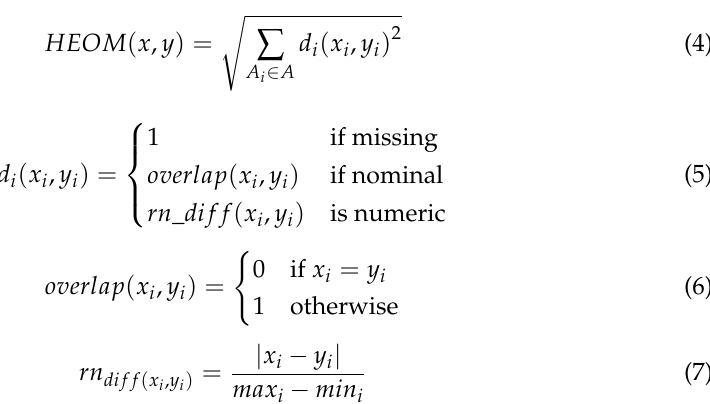
Figure 4. Distribution of clients per cluster.